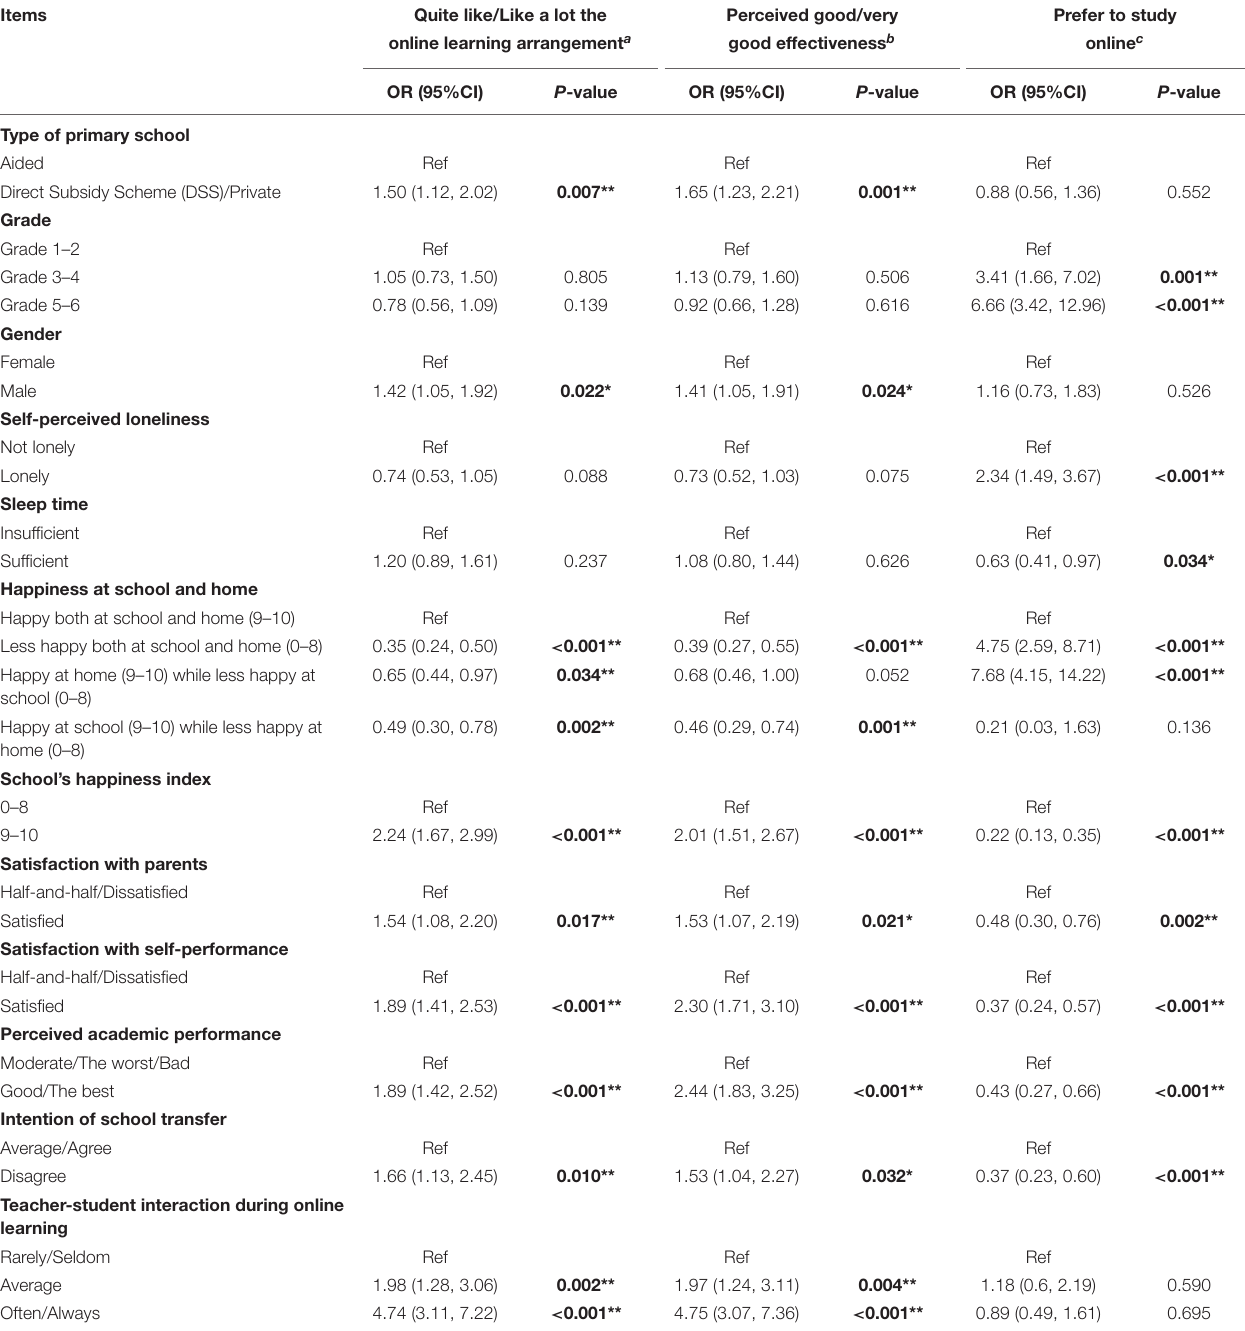
TABLE 2 | The univariate regression results of factors associated with Students’ views on online learning.ˆ Items Quite like/Like a lot the Perceived